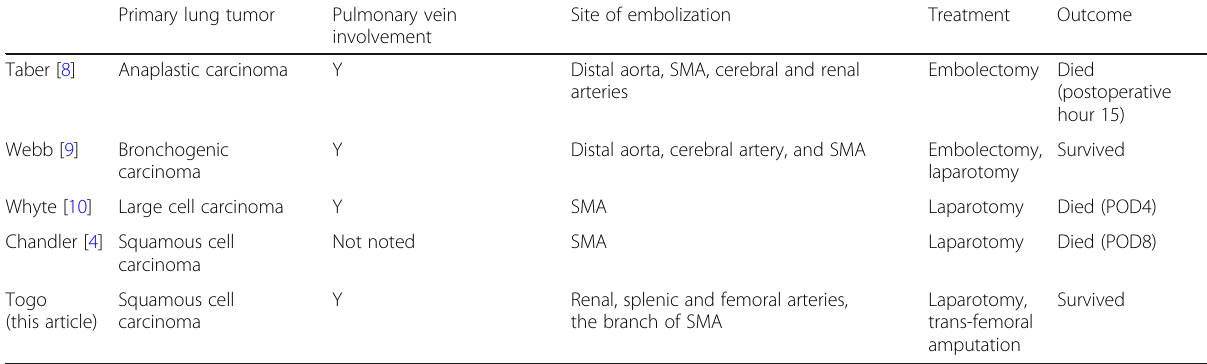
Table 1 Published reports of primary lung cancer that embolised to the superior mesenteric artery Primary lung tumor Pulmonary vein Site of involvement